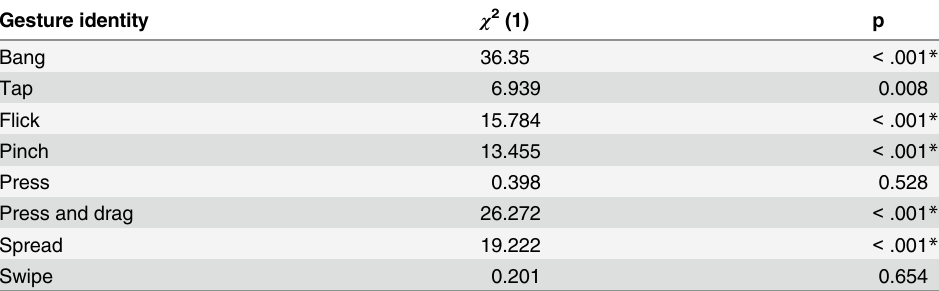
Table 2. Effects of age on interactive gestures reportedly used. Gesture identity χ 2 (1) p Bang Tap Pinch Press Press and drag 26.272 < .001 * Spread < .001 * Swipe 0.654 Results from logistic regressions attempting to predict whether parents report that their child, when interacting with the touch screen, has used a given gesture (1) or not (0) from the child ’ s age (Type II Analysis of